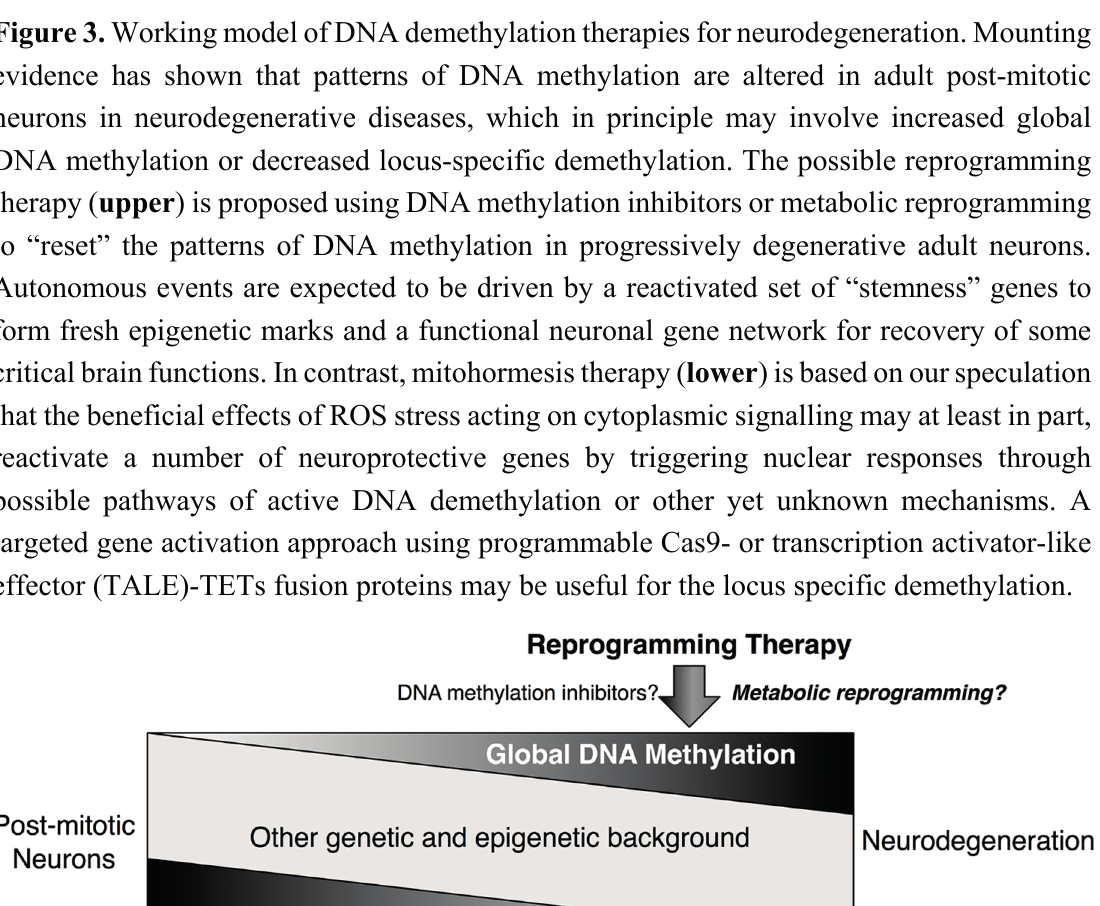
Figure 3. Working model of DNA demethylation therapies for neurodegeneration. Mounting evidence has shown that patterns of DNA methylation are altered in adult post-mitotic